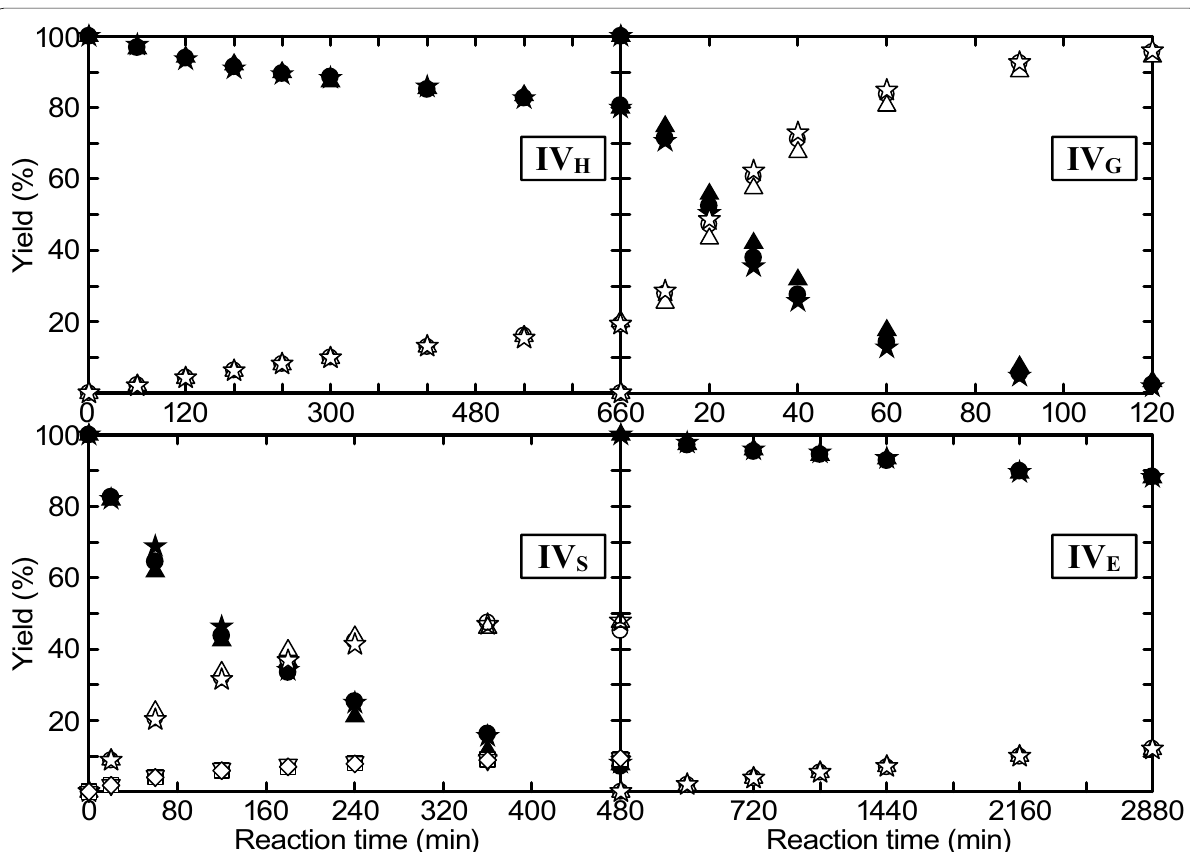
Fig. 4 Time courses of the changes in the recovery yields of compounds IV (black marks) and yields of products C (white circles, white triangles, and white stars) and B (white squares, white inverted triangles, and white diamonds). Upper left: compound IV H , upper right: compound IV G , lower left: compound IV S , lower right: compound IV E . Circles, triangles, and stars indicate the 1st, 2nd, and 3rd trials, respectively, for compounds IV and products C . Squares, inverted triangles, and diamonds indicate the 1st, 2nd, and 3rd trials, respectively, for products